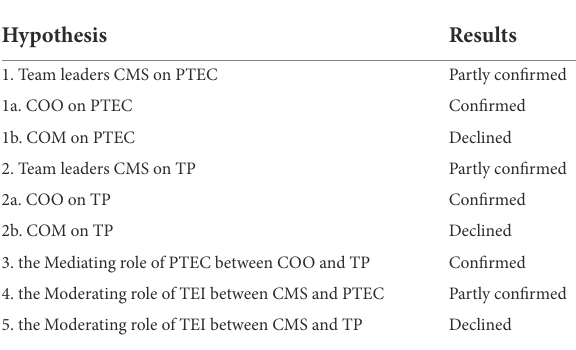
TABLE 4 Hypotheses